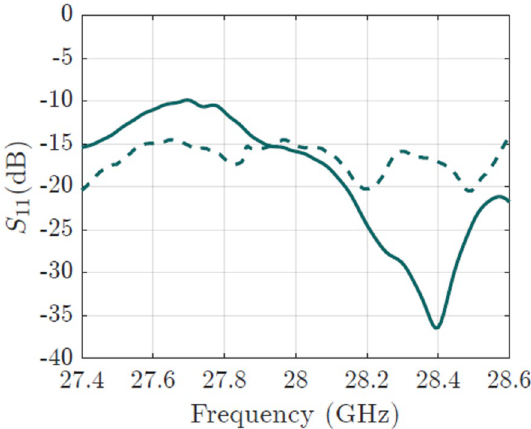
Figure 7. S 11 of the array as a function of the frequency. The solid line shows the simulated result and the dashed line the experimental one.